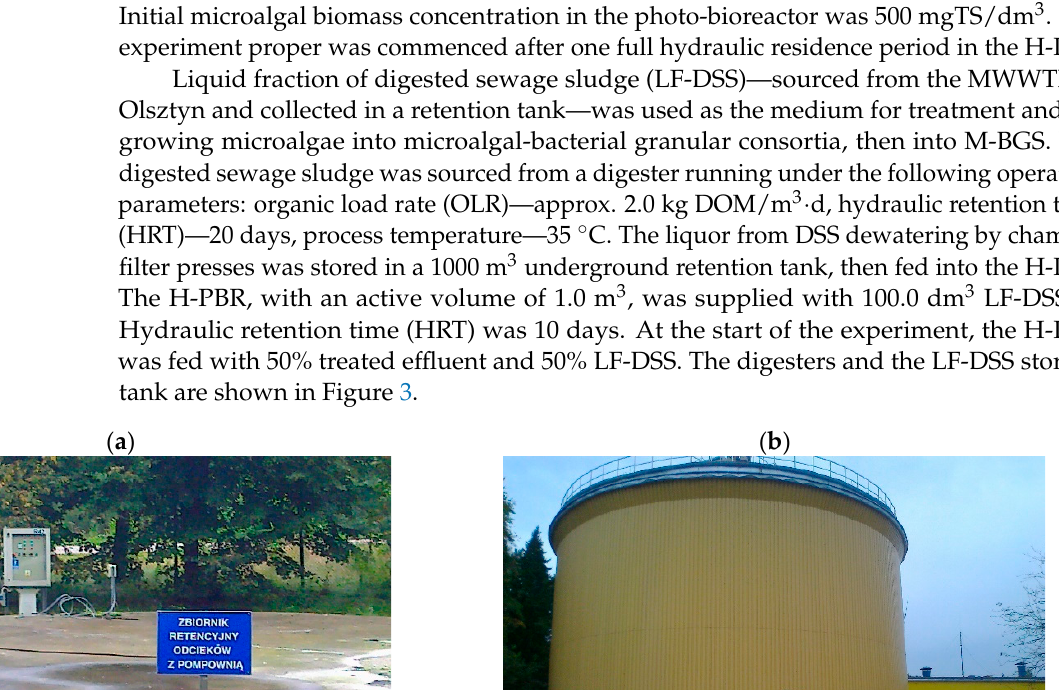
Figure 2. Location of the experiment ( a ) general view of the MWWTP “ Ł yna” in Olsztyn, ( b ) location of the semi-industrial H-PBR.